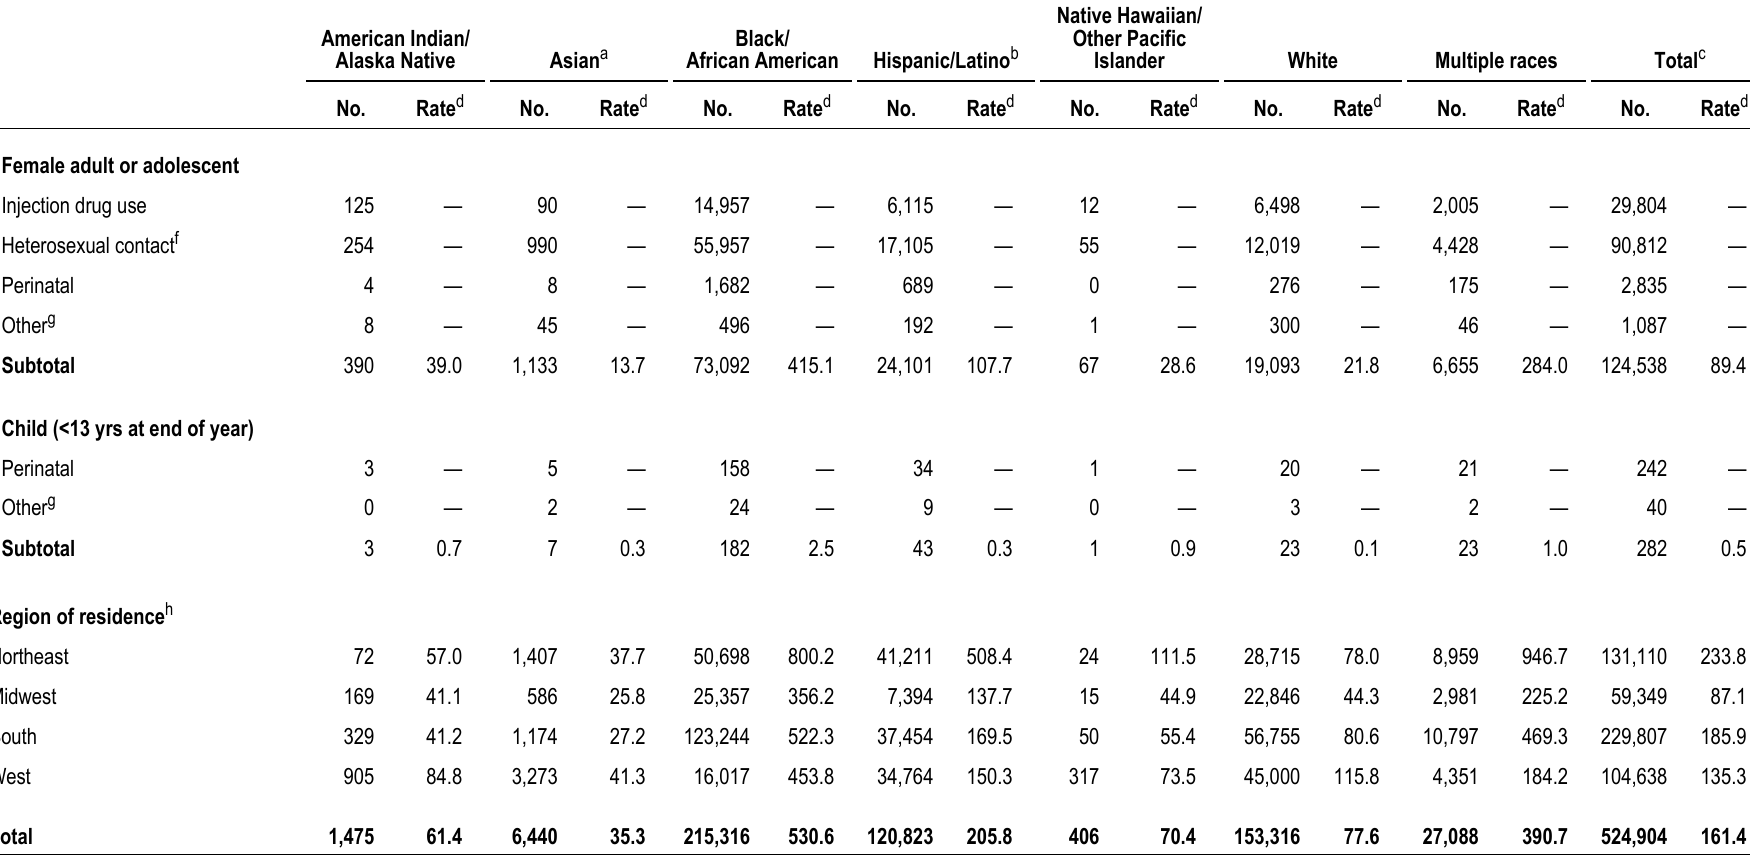
Table 25a. Persons living with diagnosed HIV infection ever classified as stage 3 (AIDS), by race/ethnicity and selected characteristics, year-end 2017—United States (cont) Native Hawaiian/ American Indian/ Black/ Other Pacific Alaska Native Asian a African American Hispanic/Latino b Islander White Multiple